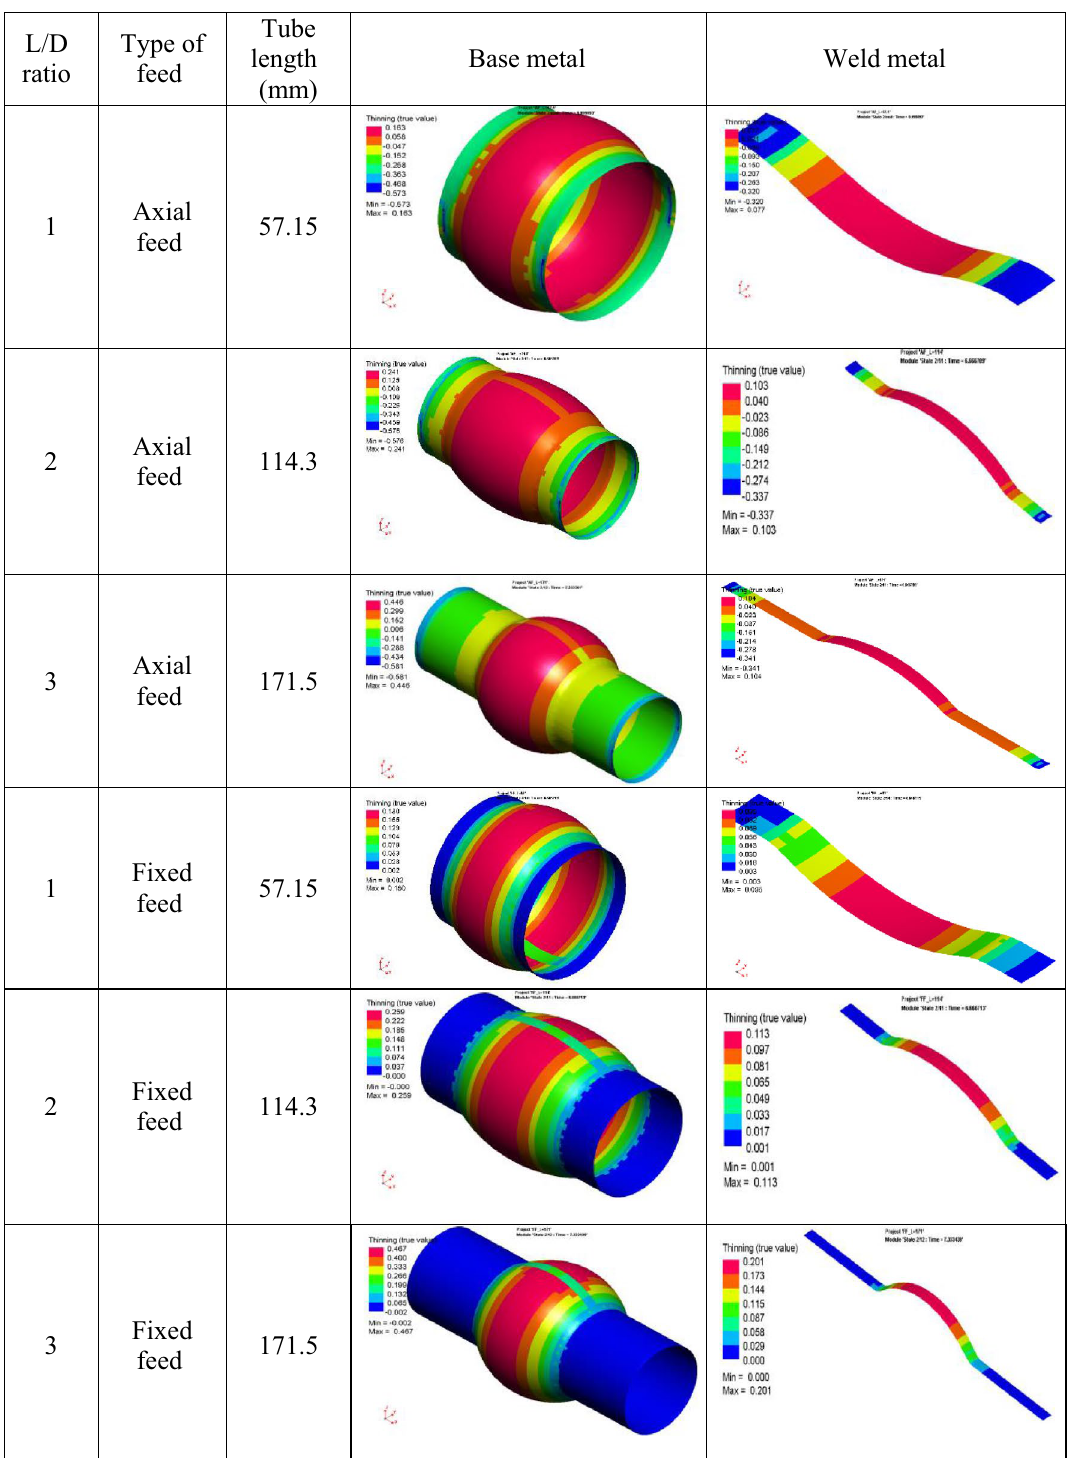
Table 5 FEA AISI304 grade material of bulging tubes for base and weld